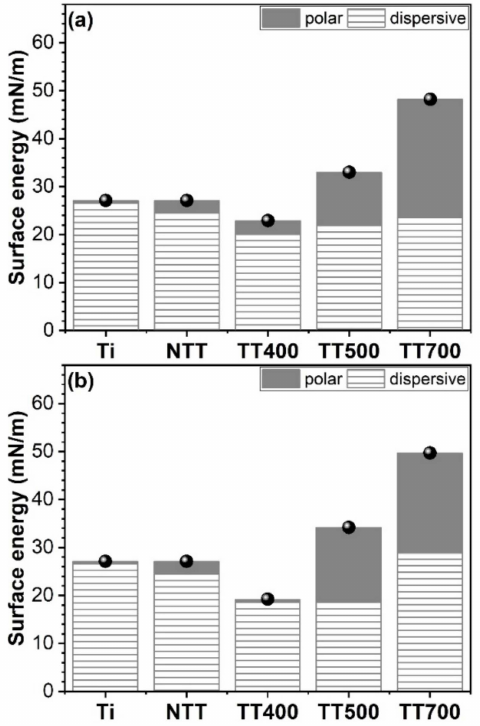
Figure 15. The surface free energy values recorded for the control (Ti), NTT LiC and for those subjected to post-deposition thermal treatments (at different temperatures), in air ( a ) and water-vapor ( b ) ambient.